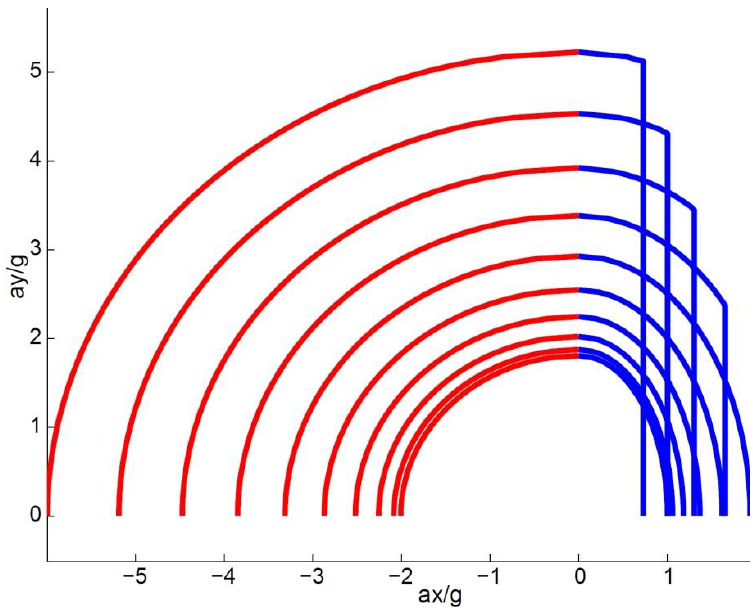
Figure 3. Performance bound for different vehicle speeds.